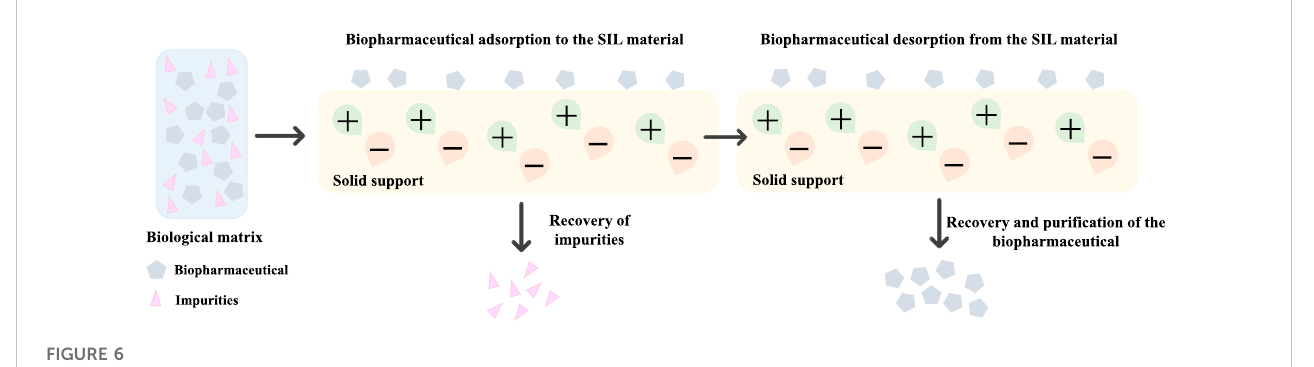
FIGURE 6 Overview of a representative SPE process using SILs for the puri fi cation of biopharmaceuticals.